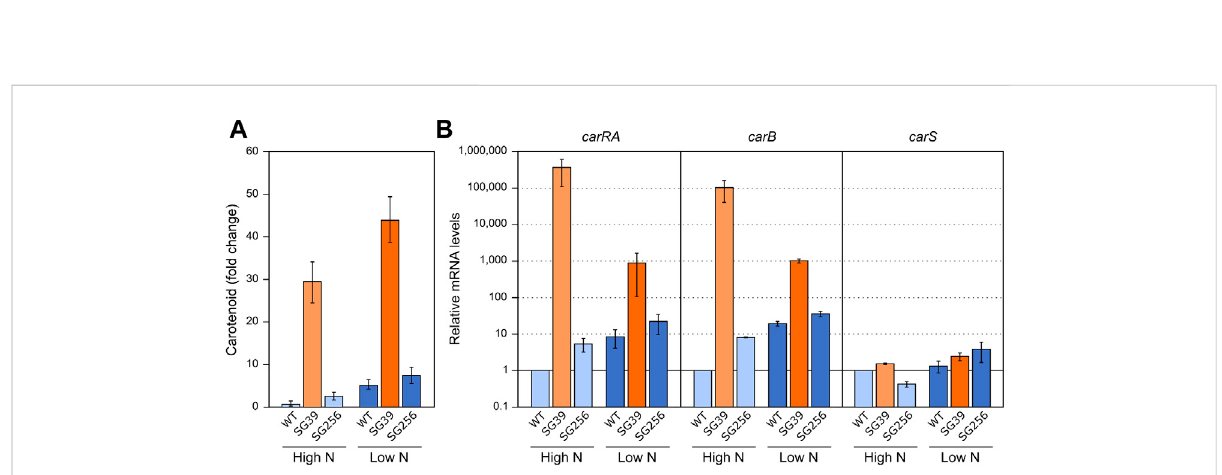
FIGURE 3 Effect of nitrogen availability and carS mutation on carotenoid production and expression of car genes. (A) Relative carotenoid production or without treatment (control) in the wild type (WT), carS mutant (SG39), and the complemented mutant (SG256) under two different nitrogen concentrations. (B) Transcript levels of carRA, carB, and carS genes at two nitrogen concentrations. The three strains were grown in DG medium for 3 days at 30 ° C in darkness with 3 g/L − 1 NaNO 3 (High N) or with 0.625 g/L − 1 NaNO 3 (Low N). Levels of mRNA were determined by RT-qPCR and referred to the levels in the wild type grown in High N, taken as 1. The Petri dishes were incubated for 24 h more before extraction of